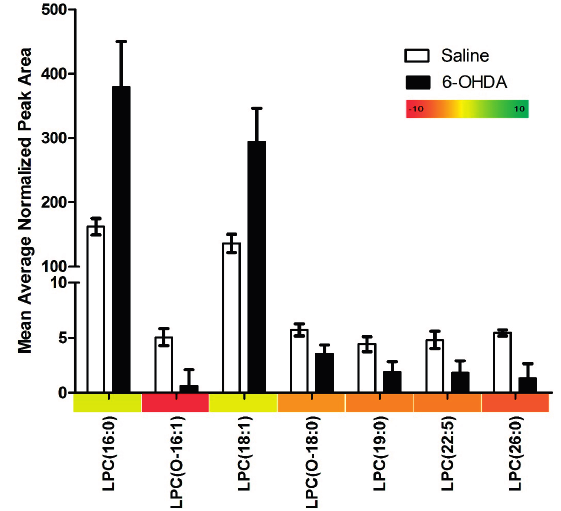
Figure 2. The relative abundance of lysophosphotidylcholine species in the substantia nigra of animals treated with either 6-OHDA (20 µg) or saline vehicle into the right anterior dorsal striatum, as determined by HPLC-ESI-MS/MS measurements. All measurements were run in triplicate and the error bars represent the standard error. Only species that were significantly differences between treatment and control groups are shown. Significance was determined by independent sample t -test. The relative fold change of lysophosphotidylcholine species is represented along the X-axis in the form of a color heat